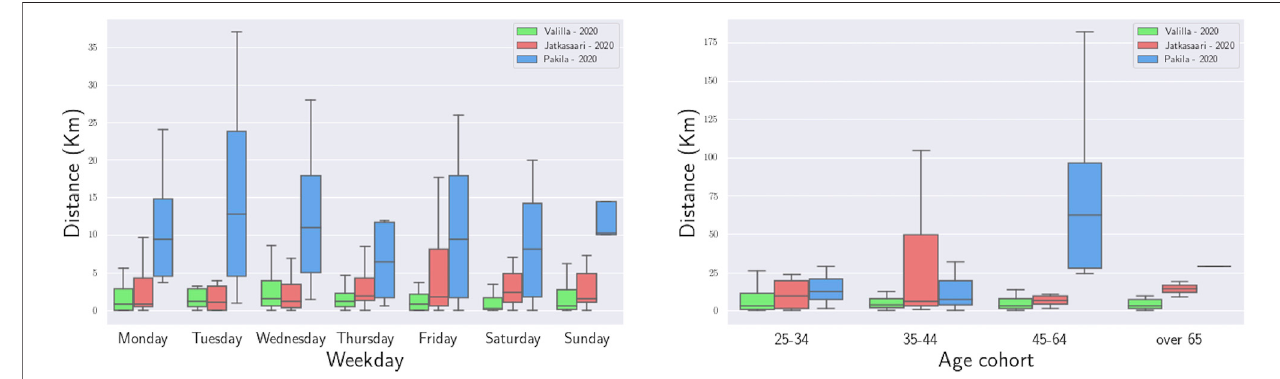
FIGURE8| Total distanceHOPE sensors units were carried forValilla and Jätkäsaari citizens summer campaign and Pakila wintercampaignagainst days ofweek and age cohort per district during data campaigns.